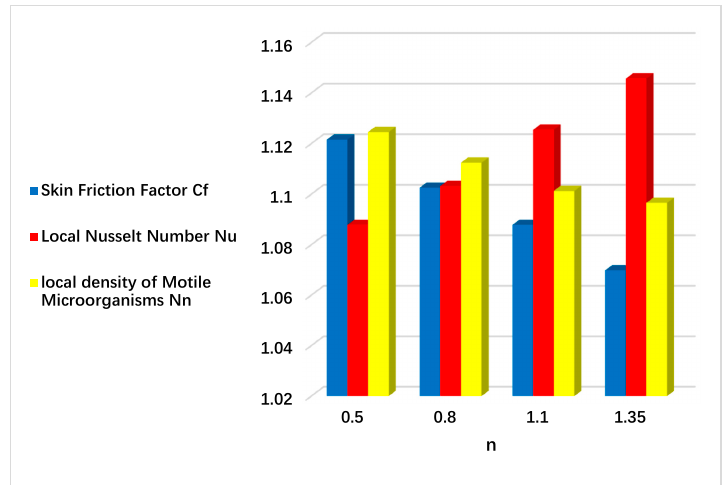
Figure 20. Impact of n on C f , Nu, and Nn . Coatings 2022 , 12 , x FOR PEER REVIEW